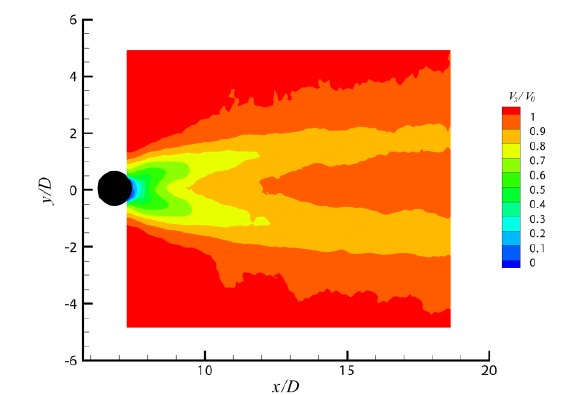
Fig. 11. Normalized mean streamwise velocity component contour plot obtained for wake region